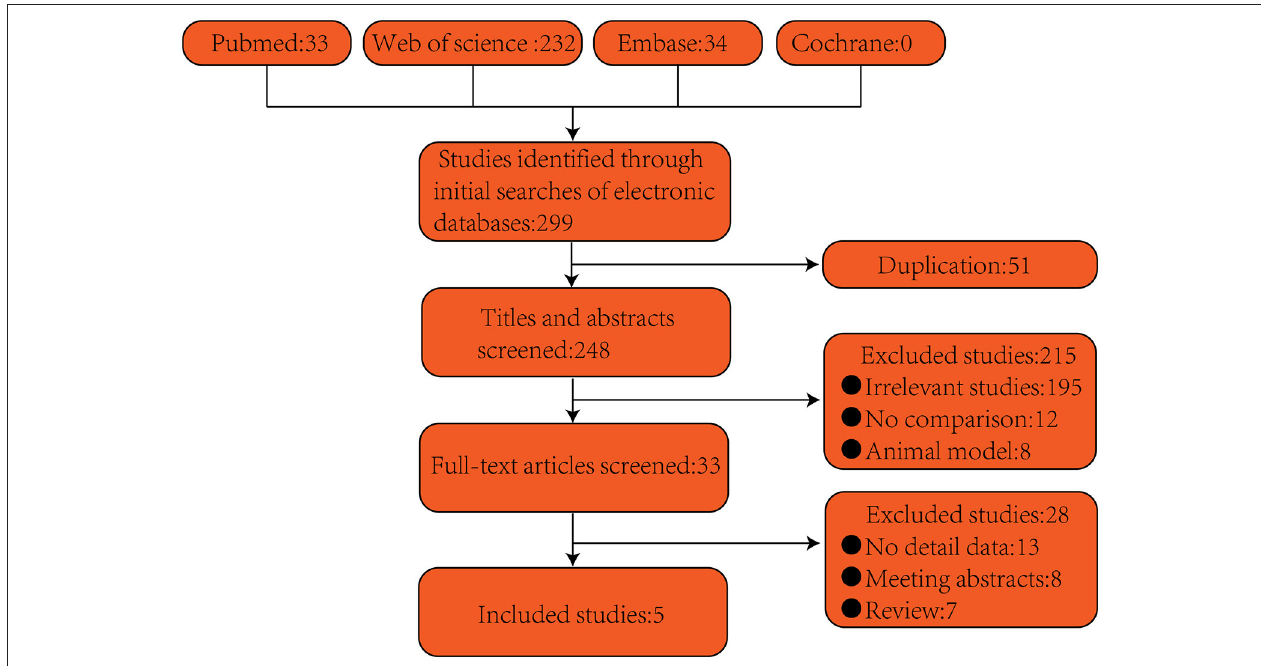
FIGURE 1 | Flow diagram of article selection.